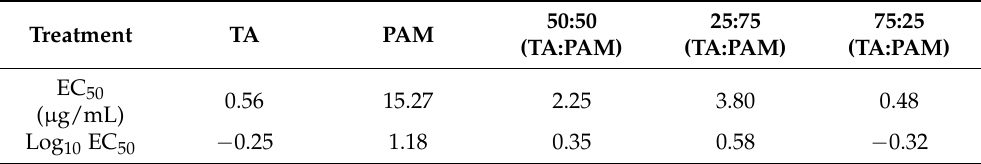
Figure 1. Percentage of cell viability (%) against log concentration of tannic acid (TA) alone, pam– dronate (PAM) alone, and percentage combination at the ratio of TA:PAM at 50:50, 25:75, and 75:25. The viability of hFOB 1.19 cells was determined by MTT assay. The values were expressed in mean ± SEM from three independent ( n = 3) experiments. Table 1. Value of half maximal effective concentration (EC 50 ) for treatment and control group on hFOB 1.19 cells.